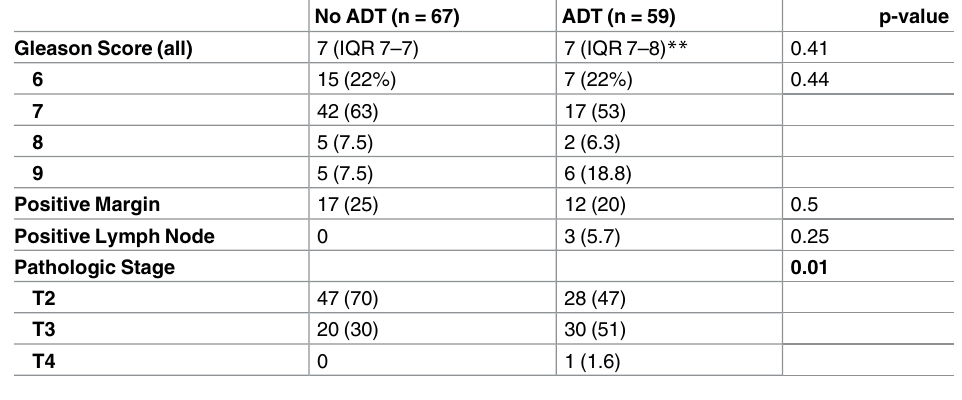
Table 2. Pathologic Data after Radical